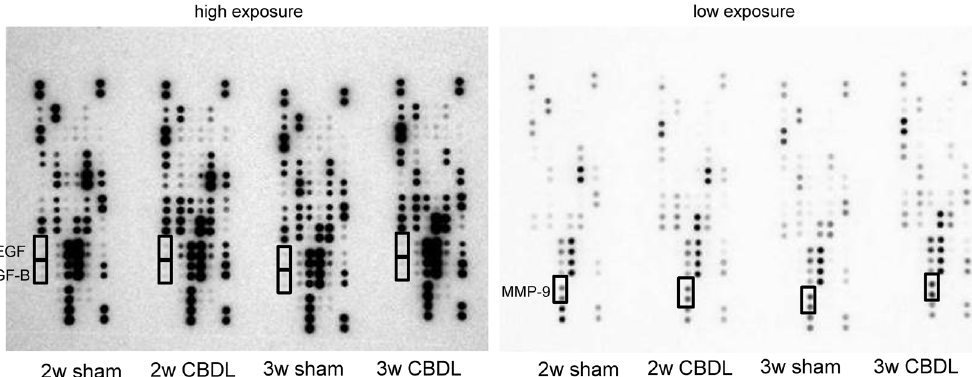
Figure 6. Protein array analysis of serum from common bile duct ligated (CBDL) and sham operated mice. Representative proteins identified using protein array analysis in serum isolated from CBDL mice and sham operated (sham) mice.